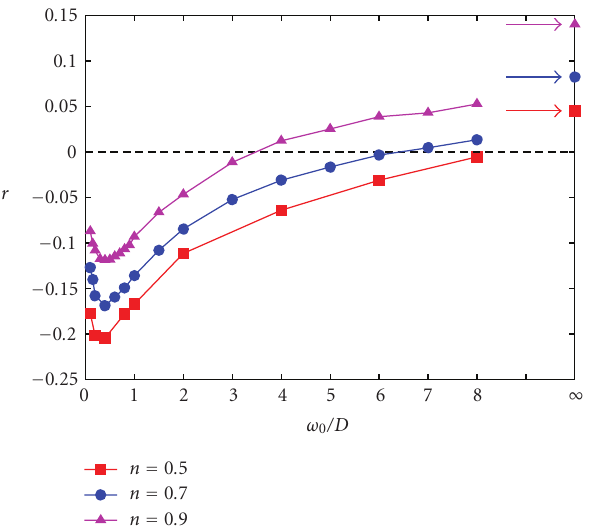
Figure 8: Renormalization of the quasiparticle electron-phonon coupling as a function of ω 0 /W for three di ff erent densities and U/W = 2 . 5 (after Sangiovanni et al. [46]).